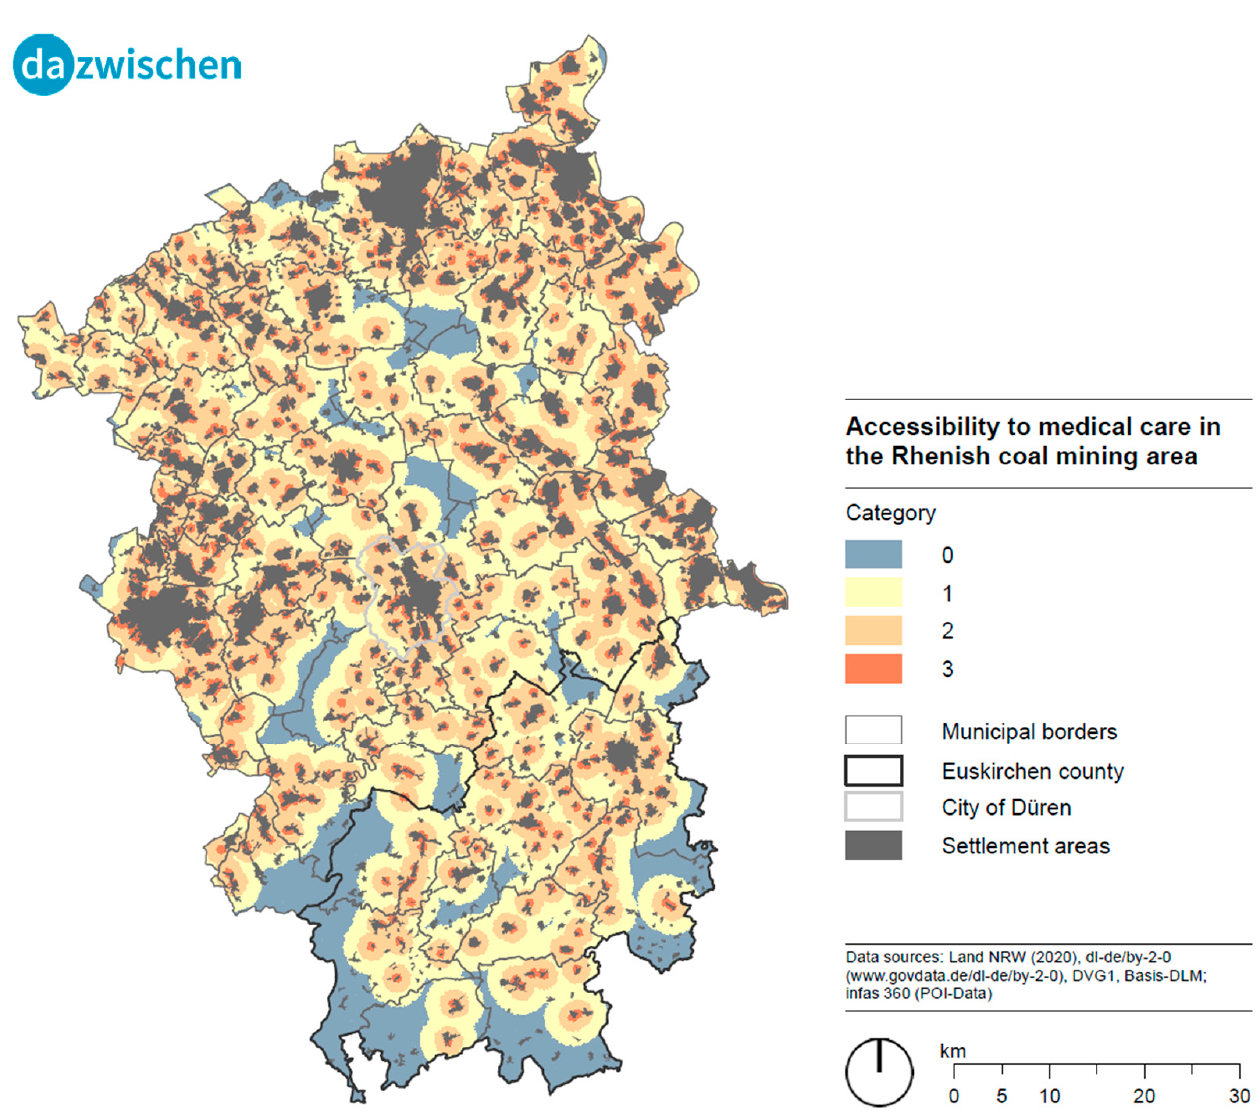
Figure 4. Accessibility to medical care. Source: own figure.